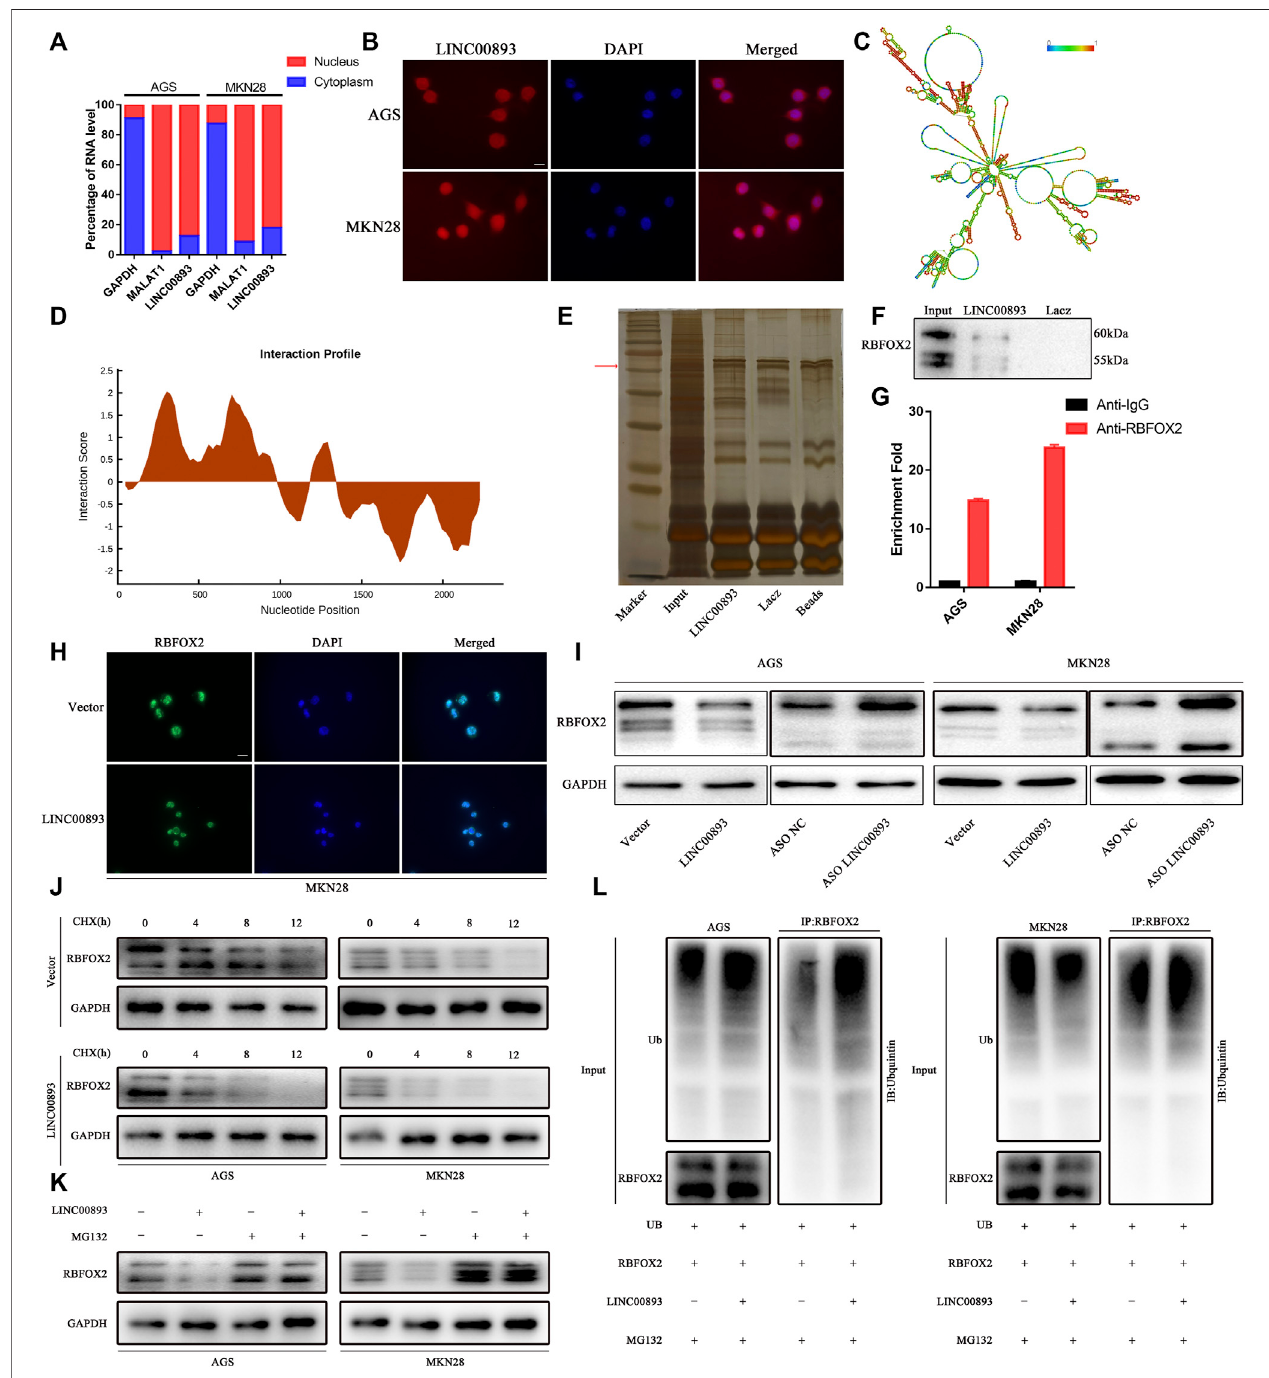
FIGURE5| Identi fi cationofRBFOX2asabindingpartnerforLINC00893 (A) RT-qPCRanalysisfromnuclearandcytoplasmicfractionsofGC cells;thecytoplasmic GAPDHmRNAandthenuclearlncRNAMALAT1wereusedascontrols (B) SubcellularlocalizationofLINC00893detectedbyFISH.Scalebar:20 μ m (C) Thesecondary structure of LINC00893 was predicted (http://rna.tbi.univie.ac.at). The red color indicates strong con fi dence for the prediction of each base (D) The potential binding areas between LINC00893 and RBFOX2 were predicted using the catRAPID database (E) SDS-PAGE of proteins puri fi ed from CHIRP assay using biotinylated LINC00893 or antisense RNA (F) Western blotting analyses following CHIRP assays in AGS cells con fi rmed the interaction between LINC00893 and RBFOX2 (G) RIP assay followed by RT-qPCR suggested LINC00893 binds to RBFOX2 (H) Representative images of immuno fl uorescence staining for RBFOX2 expression in MKN28 cells after transfection with LINC00893 overexpression or empty vectors. Scale bar: 20 μ m (I) Western blotting to analyze total level of RBFOX2 after LINC00893 were overexpressedorknockeddowninGC cells (J) ACHXtreatmentwasadministeredtoassessRBFOX2degradationinAGSandMKN28cells (K) MG-132abolishedthe downregulation of RBFOX2 protein expression induced by LINC00893 overexpression in AGS and MKN28 cells (L) Ubiquitination assays revealed that LINC00893 overexpression increased the level of the ubiquitinated RBFOX2 protein in AGS and MKN28 cells.